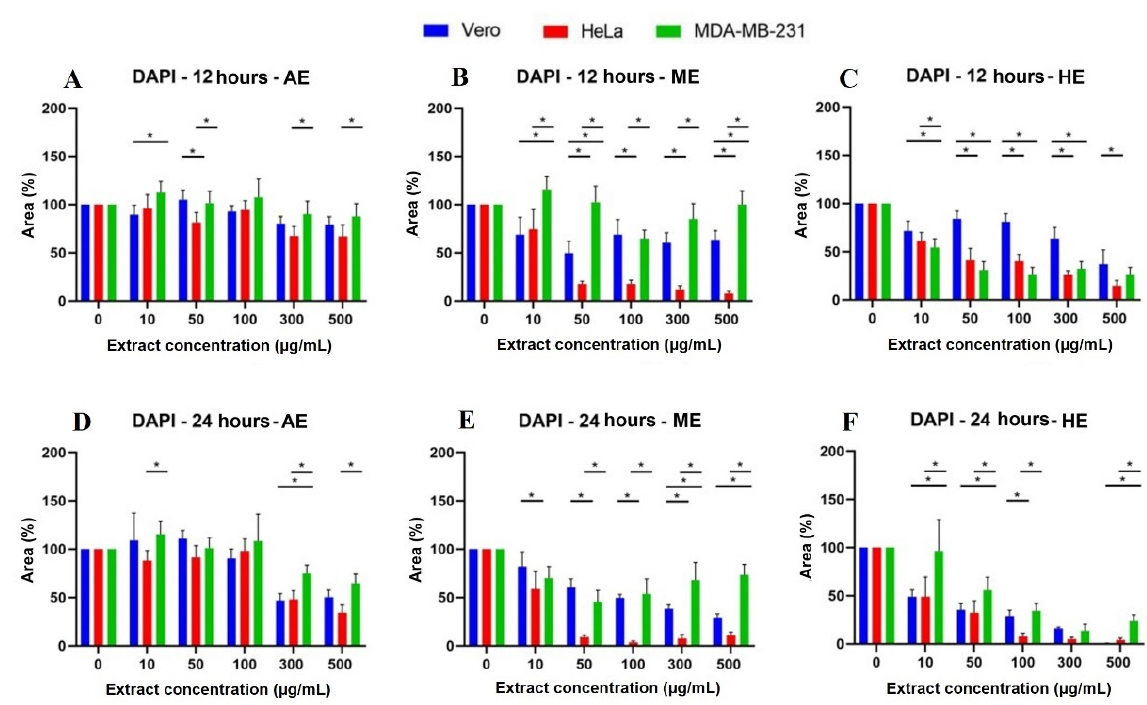
Figure 5. Quantitative analysis of nuclei labeling with DAPI in cells treated for 12 and 24 h with A. monostachya extracts. Cell area percentages are shown for Vero, HeLa, and MDA-MB-231 lines. HeLa and MDA-MB-231 lines exposed to concentrations of 0, 10, 50, 50, 100, 300, and 500 µg/mL of AE ( A. monostachya ) are shown for µg/mL of AE ( A , D ), ME ( B , E ), and HE ( C , F ). n = 8. * p < 0.05, Tukey’s multiple comparison test vs. Vero cells.